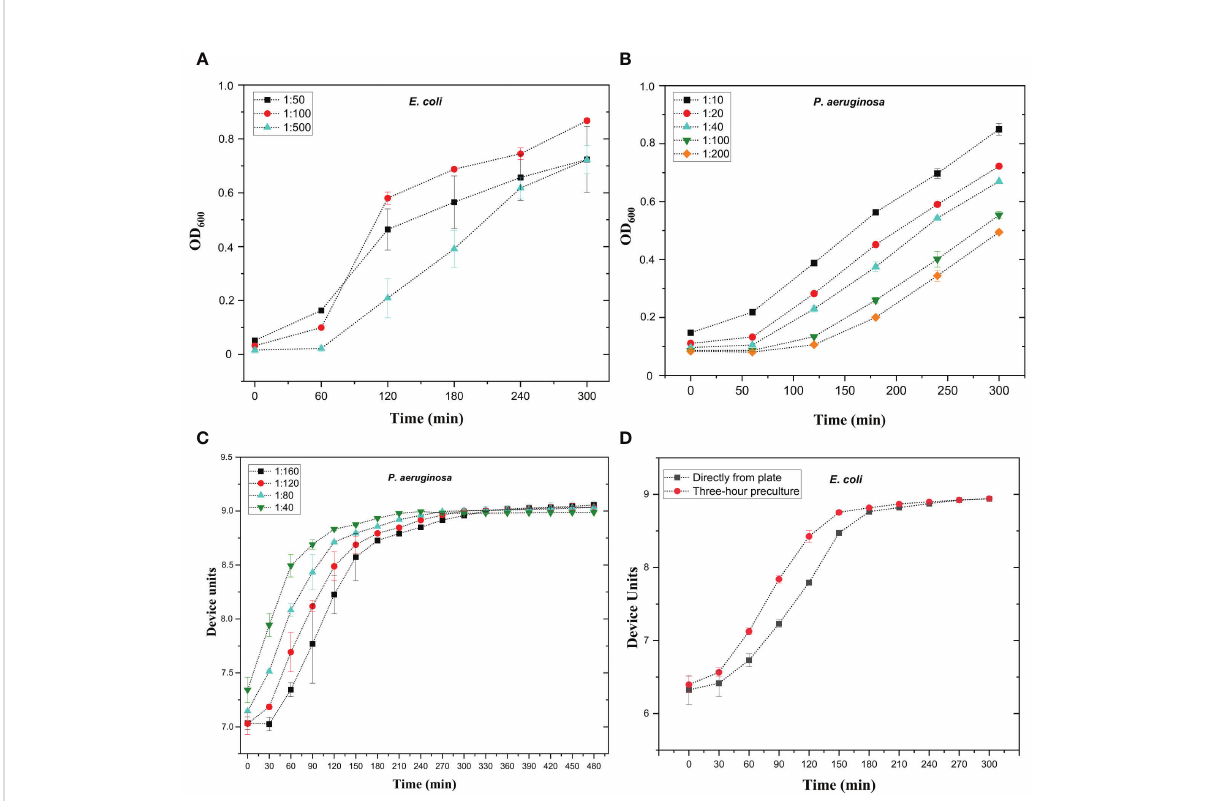
FIGURE 1 Optimization of bacterial growth curves with optical density reader (A, B) and microscopy reader (C, D) . (A) Growth curves of E . coli strain #5506 in absorbance reader. Overnight bacterial culture was diluted in lysogeny broth (LB) to 1:50, 1:100, and 1:500 dilutions. Bacterial dilutions were added in 200 µl volumes into microtiter well plate and bacterial growth was measured using absorbance reader with optical density (OD) at 600 nm at one-hour intervals for 5 hours. (B) Growth curves of P. aeruginosa strain #6329 in absorbance reader. Overnight bacterial culture was diluted in lysogeny broth (LB) to 1.10, 1:20, 1:40, 1:100, and 1:200 dilutions. Bacterial dilutions were added in 200 µl volumes into microtiter well plate and bacterial growth was measured as in A. (C) Growth curves of P. aeruginosa strain #6329 with oCelloScope microscope. Overnight bacterial culture was diluted in LB to 1:40, 1:80, 1:120, and 1:160. Diluted culture was added in 200 µl volume into the microtiter well plate. Bacterial growth was followed at 30-minute intervals for eight hours. (D) Growth curves of E . coli strain #5521 with microscopy reader. Bacteria were either pre-cultured for three hours or picked directly from plate and suspended in LB. The OD of the 3-hour pre-culture was adjusted to 0.35 and further diluted 1:200, and 200 µl of the dilution was aliquoted into microtiter plate wells. Bacterial growth was followed at 30-minute intervals for fi ve hours. Device units indicate the microscopy reader values. Each sample was measured in triplicate; mean values and SD are